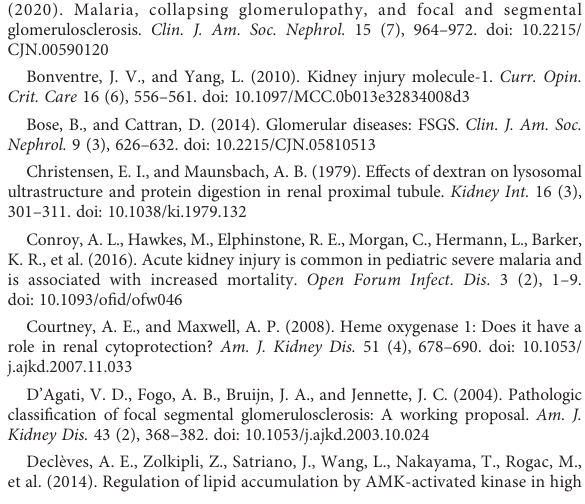
SUPPLEMENTARY FIGURE 3 Similar collapse of glomerular capillary tuft in kidneys of WT and SBP-1 KO infected mice. C57BL/6 mice were infected with WT and SBP-1 KO Pb NK65 parasitesandatday 7and8p.i. kidneyswere dissected.Sectionswerestained with PAS. Representative images are shown (original magni fi cation x20, bar